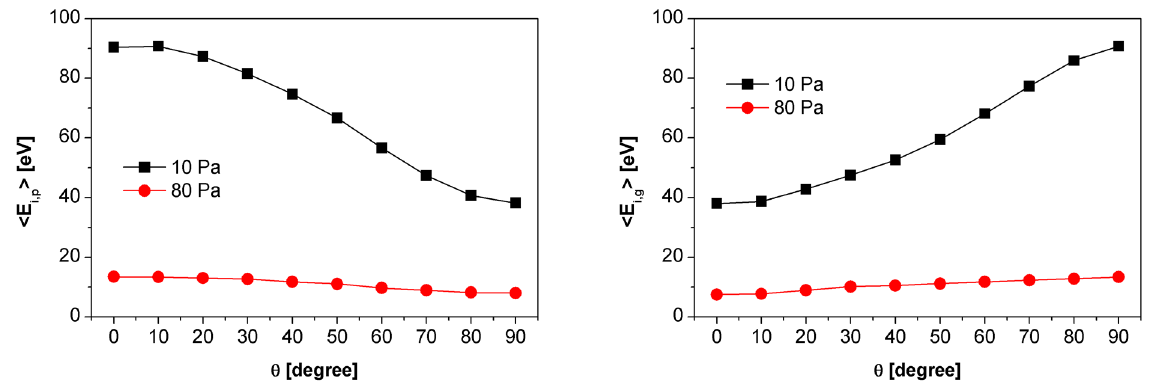
Figure 12 : Mean ion energy at the powered (left plot) and grounded (right plot) electrode as a function of θ in electrically asymmetric dual- frequency discharges operated at 13.56 MHz + 27.12 MHz at 10 Pa, Φ